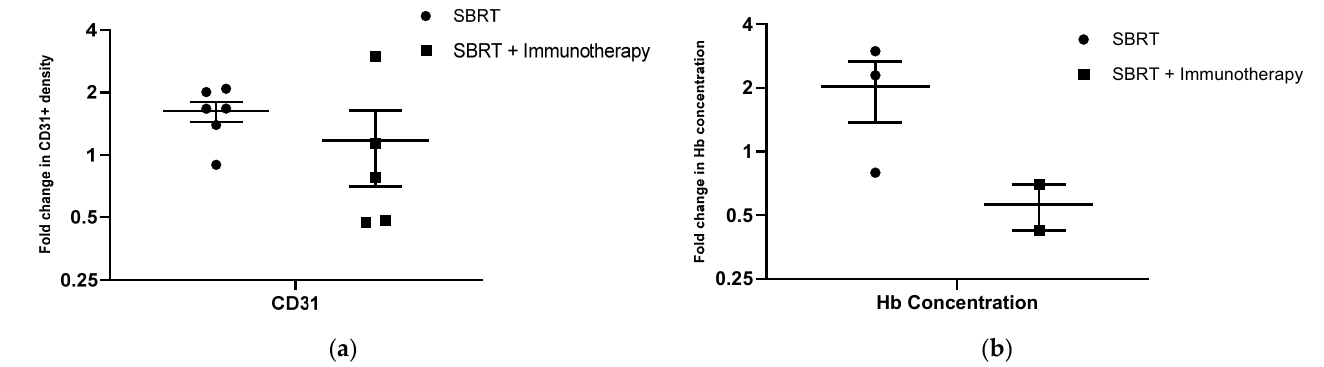
Figure 5. Tissue vascularity and oxygenation associated with SBRT or SBRT and immunotherapy. ( a ) Fold change in density of CD31+ endothelial cells in post-treatment relative to pre-treatment samples for dogs treated with SBRT or SBRT + immunotherapy (SBRT n = 6, SBRT and immuno-